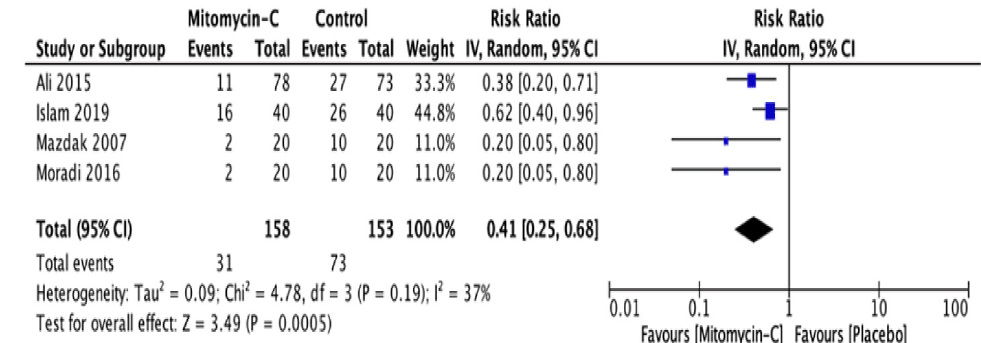
Figure 3. Forest plot for recurrence rate. Test for heterogeneity Tau-square = 0.09; chi-square = 4.78; df = 3; p-value = 0.19; I-squared =